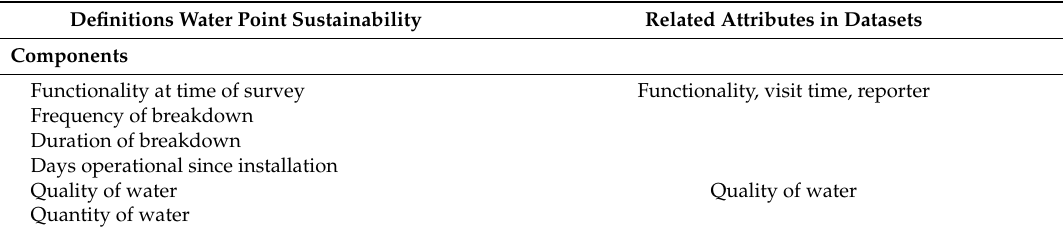
Figure 5. Spatial coverage of attribute information available in all datasets combined. Table 5. Overview of attributes found in the datasets that relate to the components and proximate explanatory variables for water point sustainability [41].